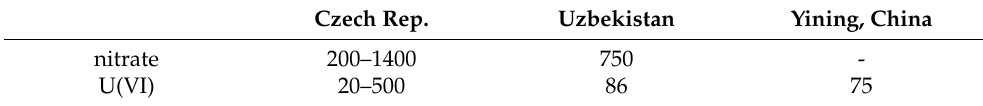
Table 1. Leaching solution quality in some in situ leaching mines (mg L − 1 ).